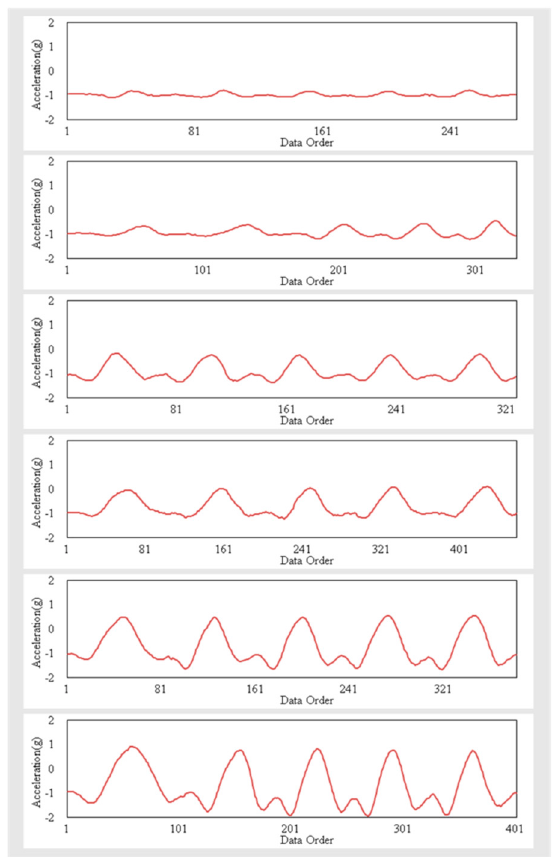
Figure 3. Flexion motion’s y-axis’s filtered data from top to bottom as ST2, ST3, ST4, ST5, ST6, Healthy.